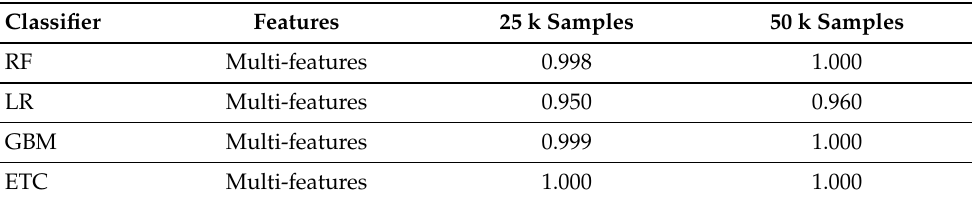
Table 8. Models’ performance using multi-features from principal component analysis (PCA) and singular vector decomposition